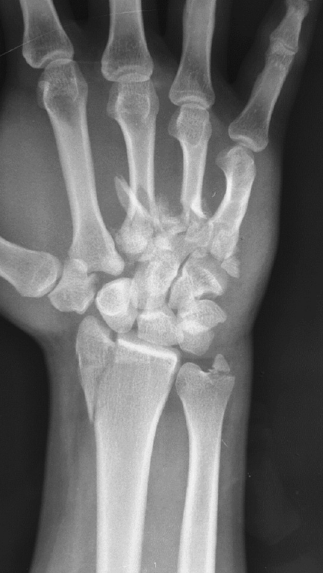
Radiograph shows the injuries of patient’s right hand. Fig. 1: